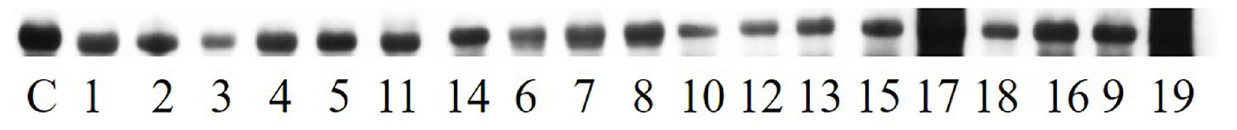
FIGURE 2 | Results obtained with WB on samples collected from healthy dogs (lanes 1–4) and from clinically sick dogs (5–19). The control sample (serum oxidized with CSE) has been loaded on lane C. Dog serum proteins has been separated in SDS-PAGE, transferred to PVDF membrane and immunodetected with specific